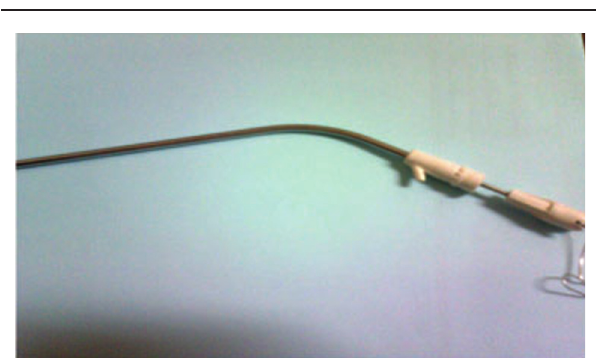
Laryngeal blade of microdebrider used in this study.